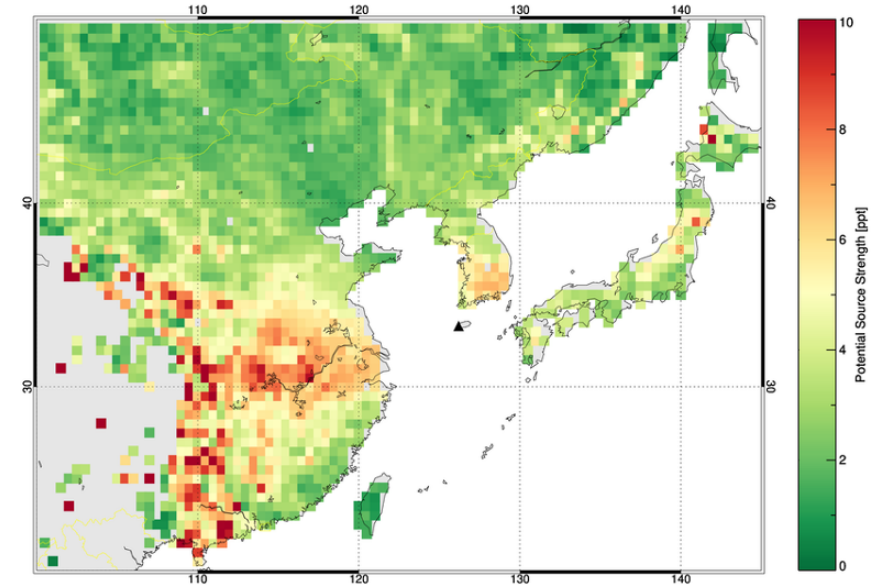
Figure 5. Potential source regions for CH 3 Br emissions derived by back-trajectory analyses of enhanced CH 3 Br mole fractions measured at Gosan station from 2008 to 2019. The location of Gosan station is represented as a black